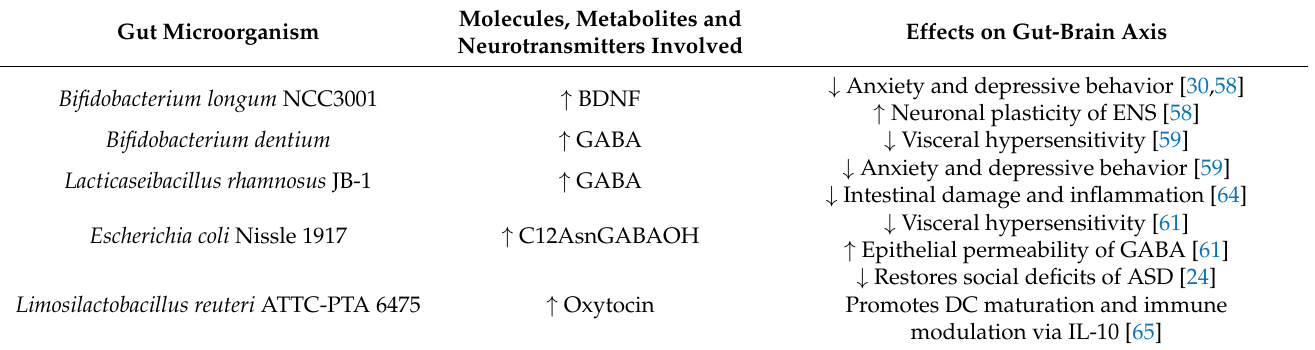
Table 1. Examples of gut microorganisms that are able to produce molecules with effects on CNS and behavior ( ↑ = increase; ↓ =